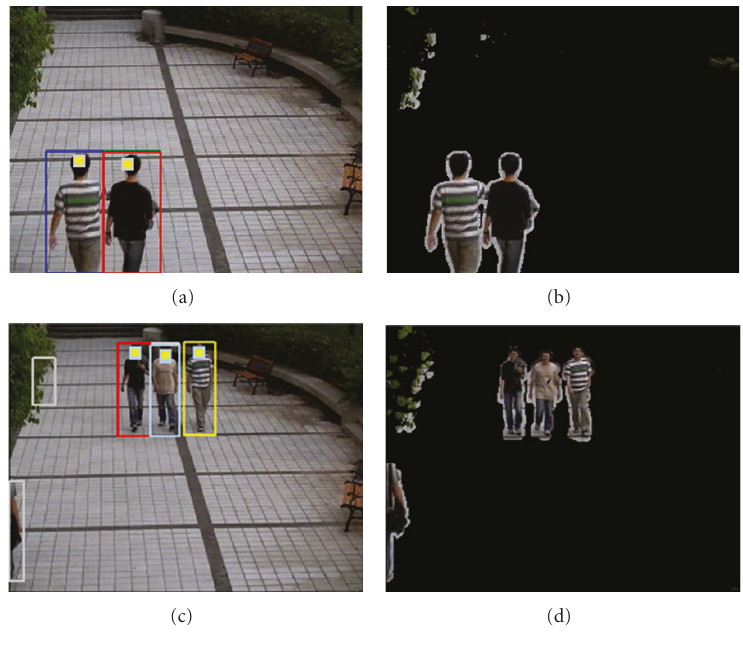
Figure 6: The results of separate humans.